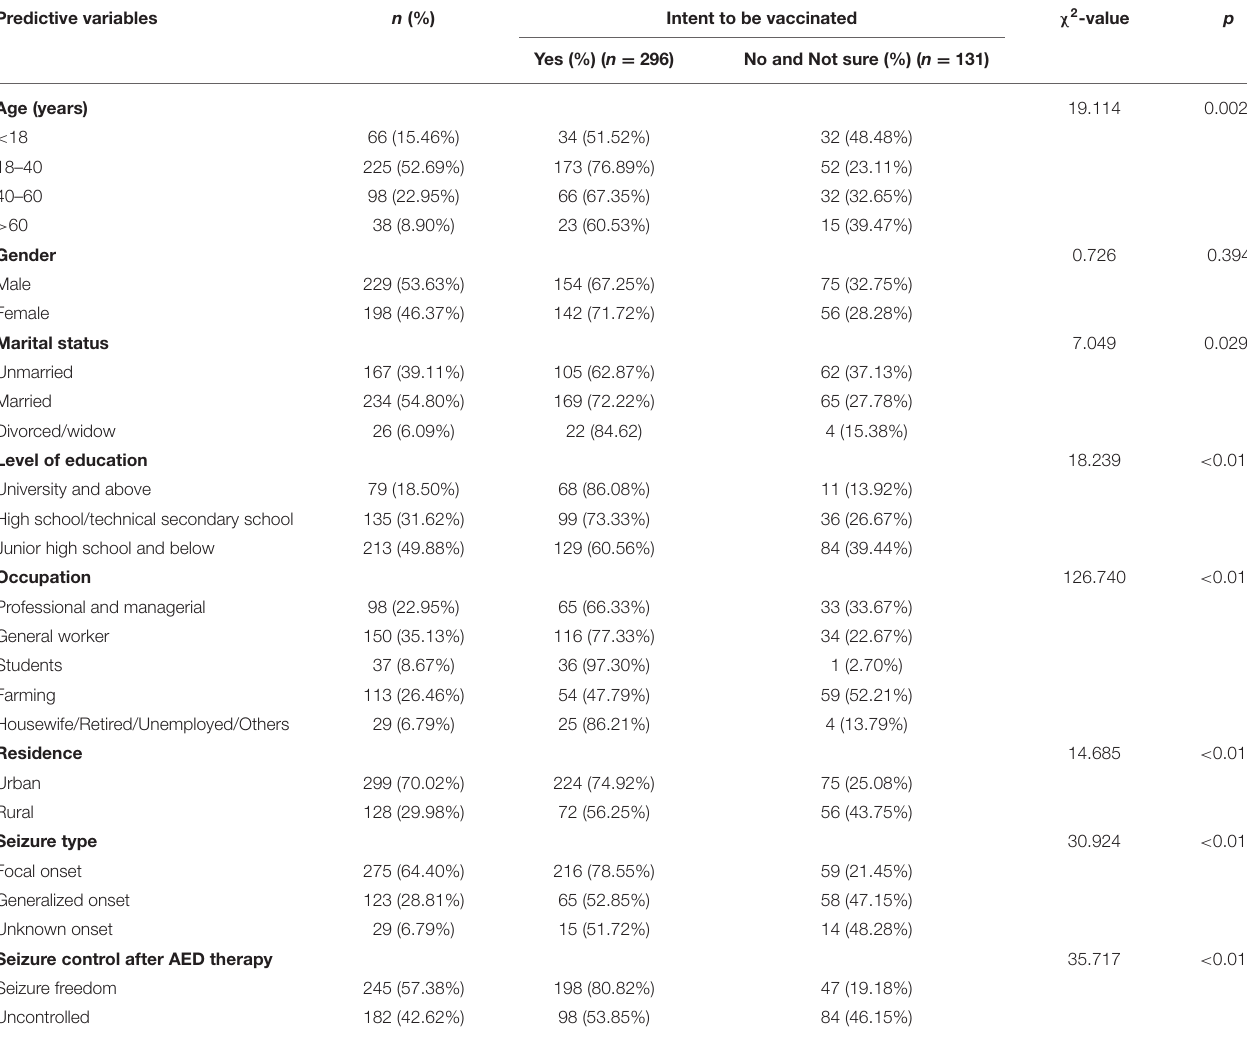
TABLE 3 | Sociodemographic characteristics and willingness to receive the COVID-19 vaccine among patients with epilepsy ( n = 427). Predictive